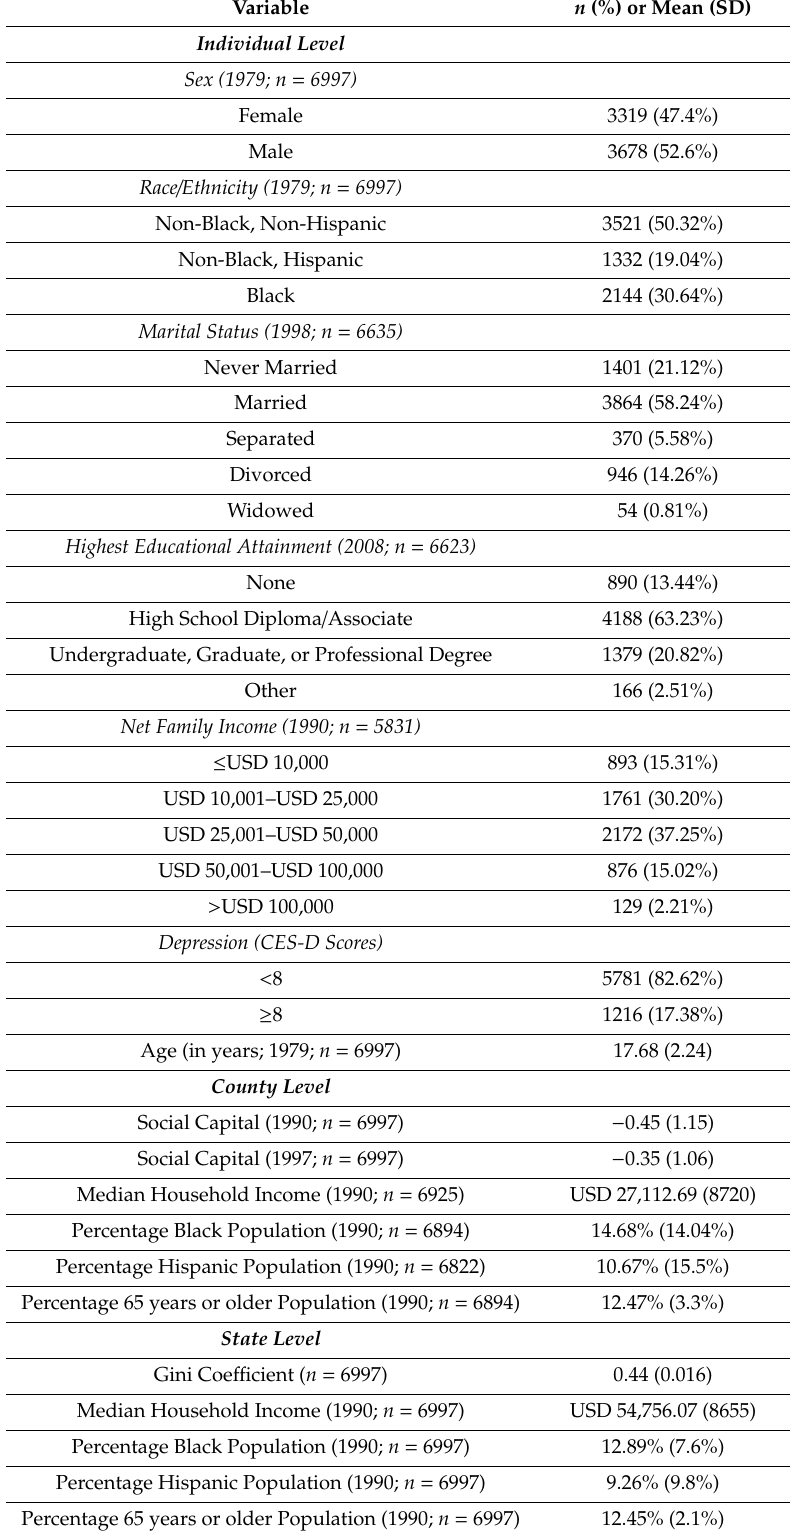
Table 1. Sample Characteristics ( n =